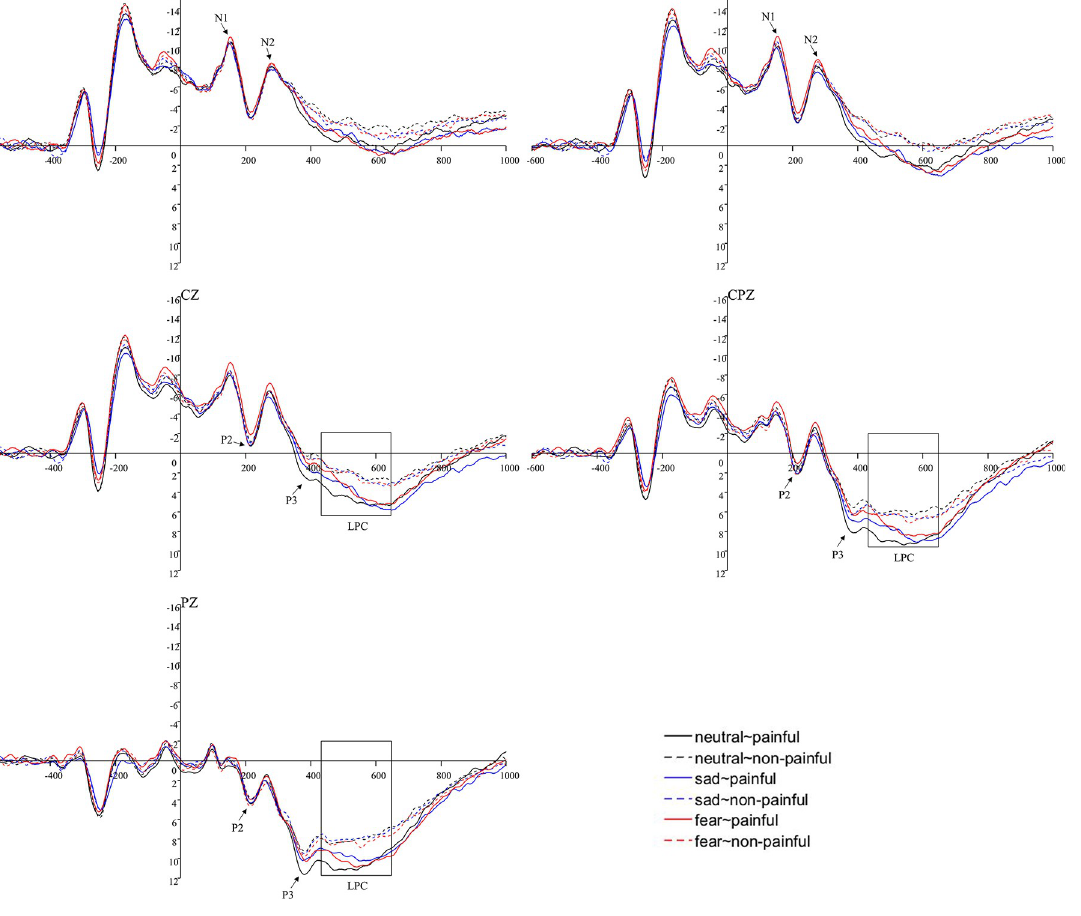
Fig 3. Illustration of ERP results at representative